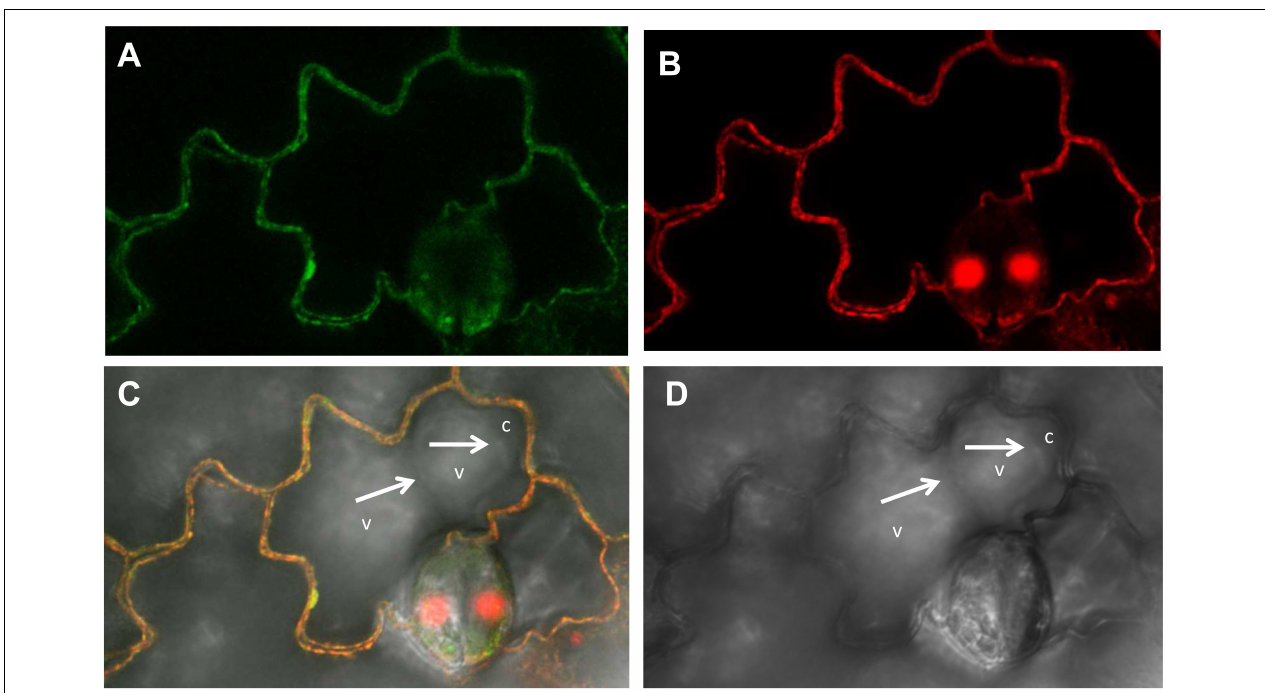
FIGURE 9 | Plasma membrane localization of the NtZIP4B-GFP fusion protein transiently expressed in the lower epidermis of tobacco leaf. Laser scanning confocal micrographs include: (A) GFP fluorescence concentrated to the cell’s contours, autofluorescence of the cell wall of non-transformed cells is below the detection limit for settings used for visualization of the GFP signal; (B) propidium iodide red fluorescence of the cell’s contours; (C) overlapped GFP and propidium iodide signal – both signals with the same localization; (D) bright field. (C,D) White arrows indicate localization of the tonoplast at the border between two vacuoles (v), and at the border between the vacuole and the cytoplasm (c) pushed into a protruding end of a cell. Green and red fluorescence is not present in the tonoplast (at the border between the vacuoles, and between the vacuole and the cytoplasm within the protruding end of a cell).